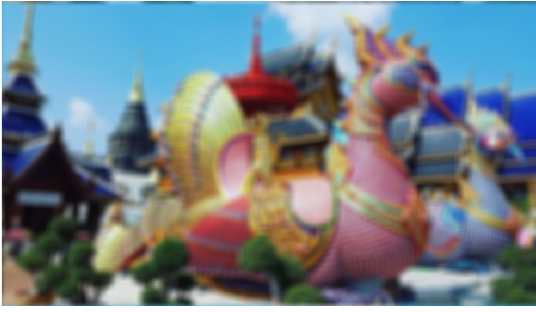
Gaussian Blurred Image with hsize = [9x9] and = 4